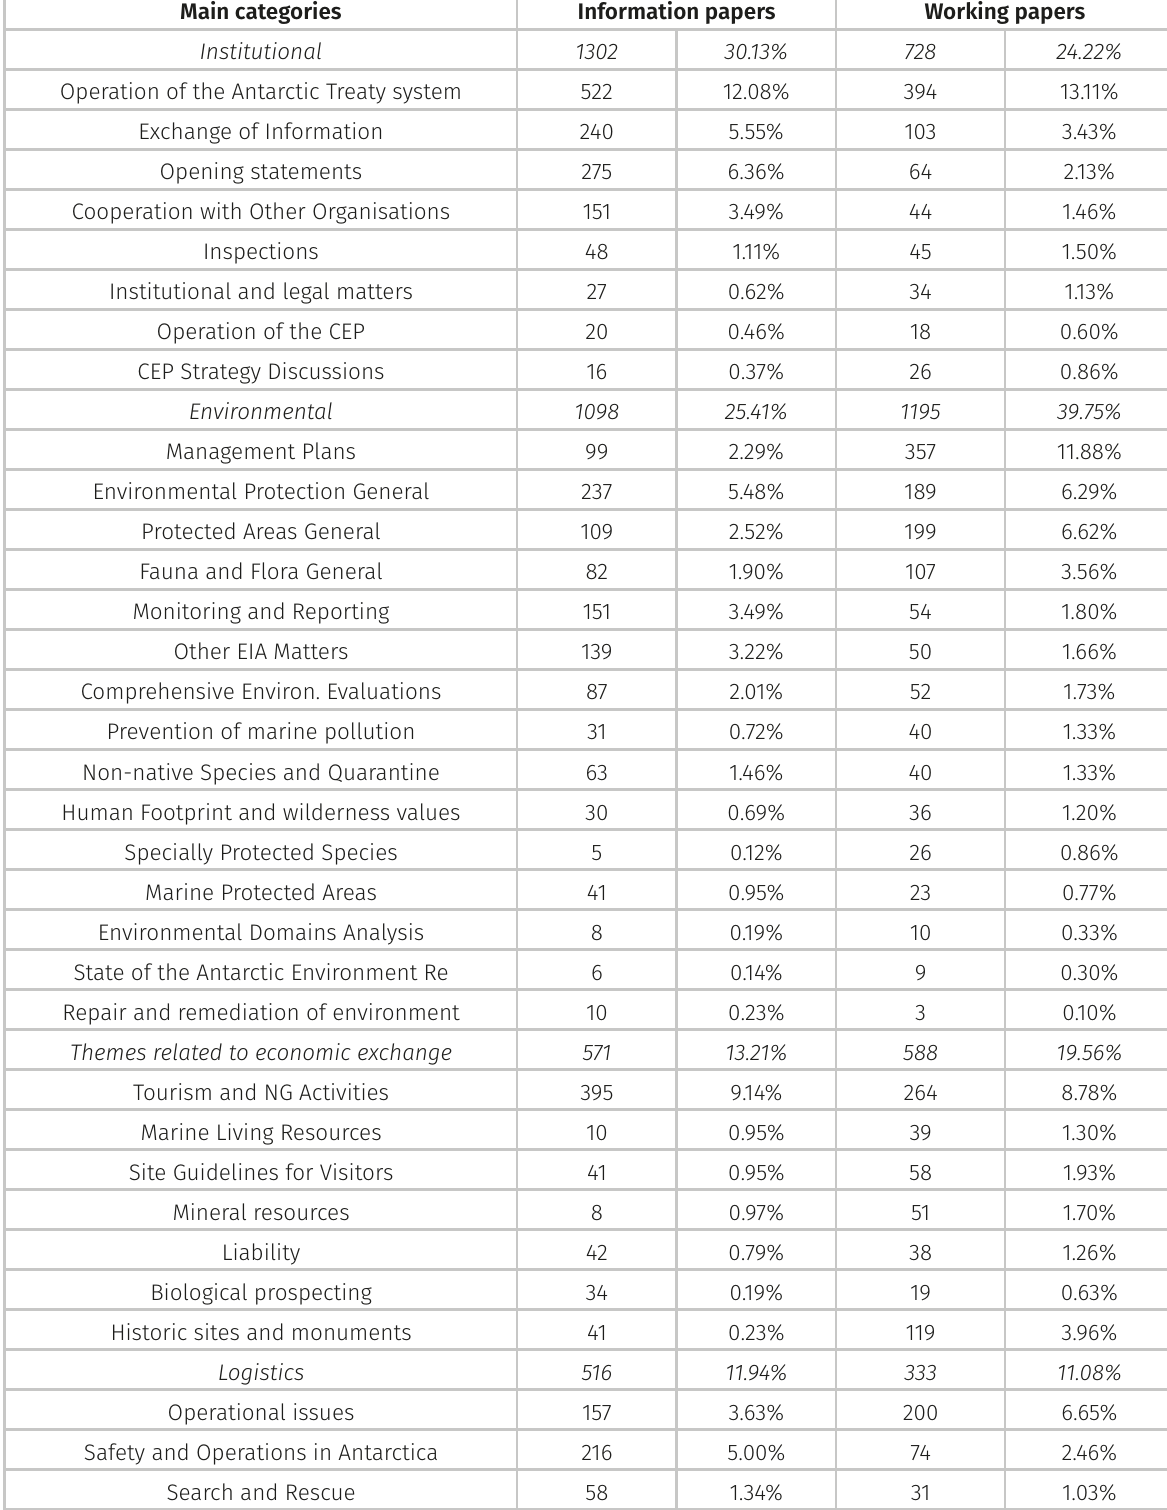
Table I. Main categories for information papers and working papers from 1961 to